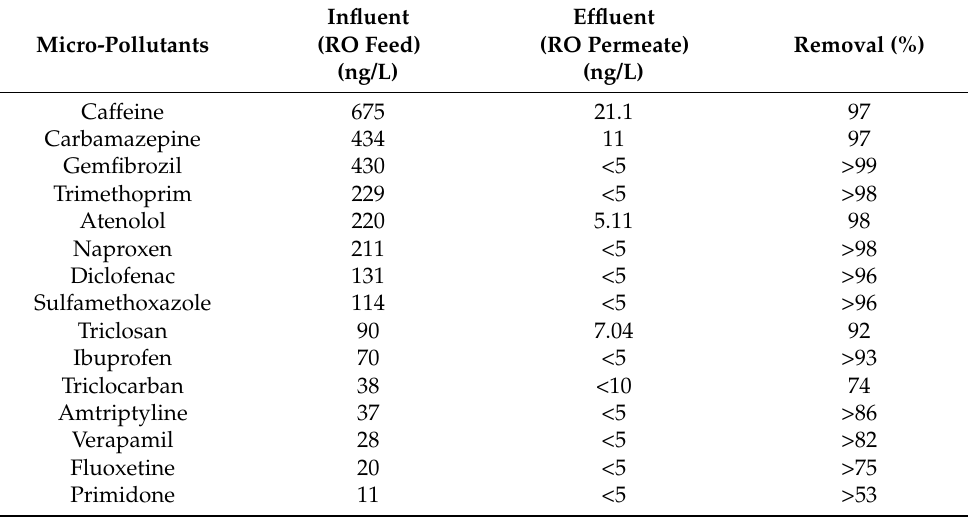
Table 5. Removal of micro-pollutants by RO membrane at operating pressure of 40